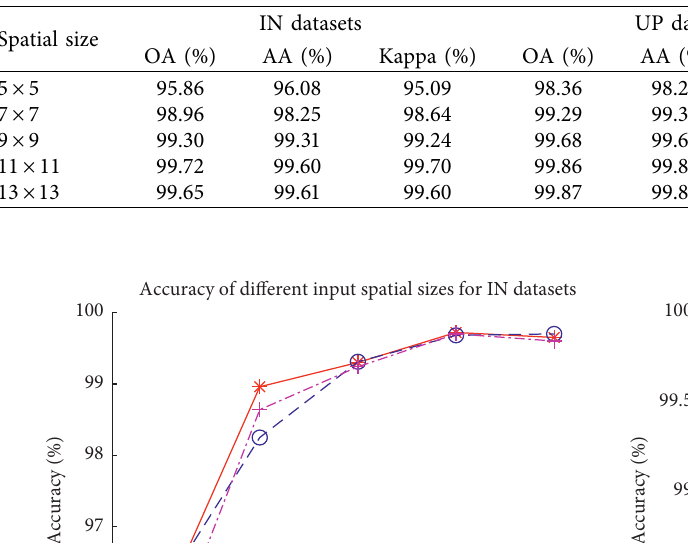
Figure 8: Accuracy of different training samples for three datasets: (a) IN; (b) UP; (c) SA. Table 3: Accuracy of different spatial sizes.